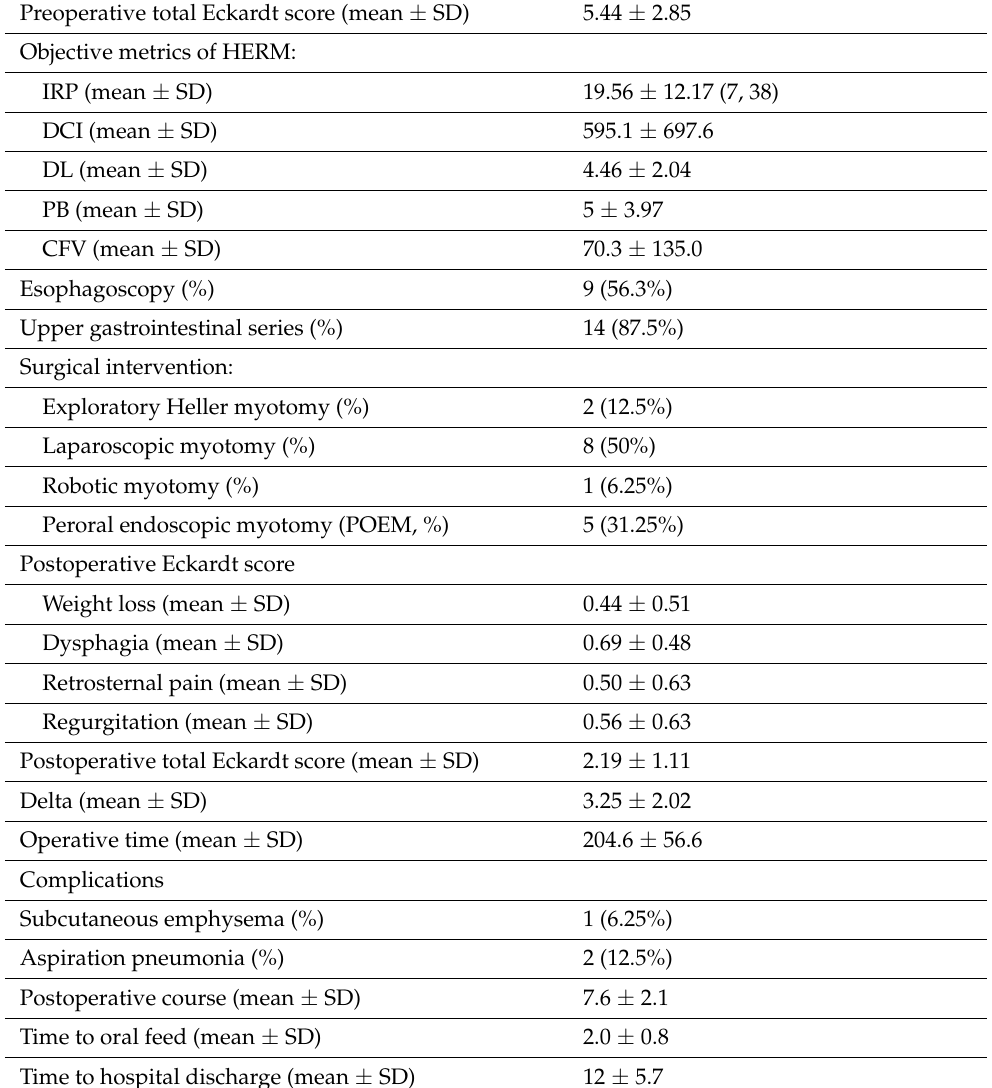
Table 2. Cont . Preoperative total Eckardt score (mean ±